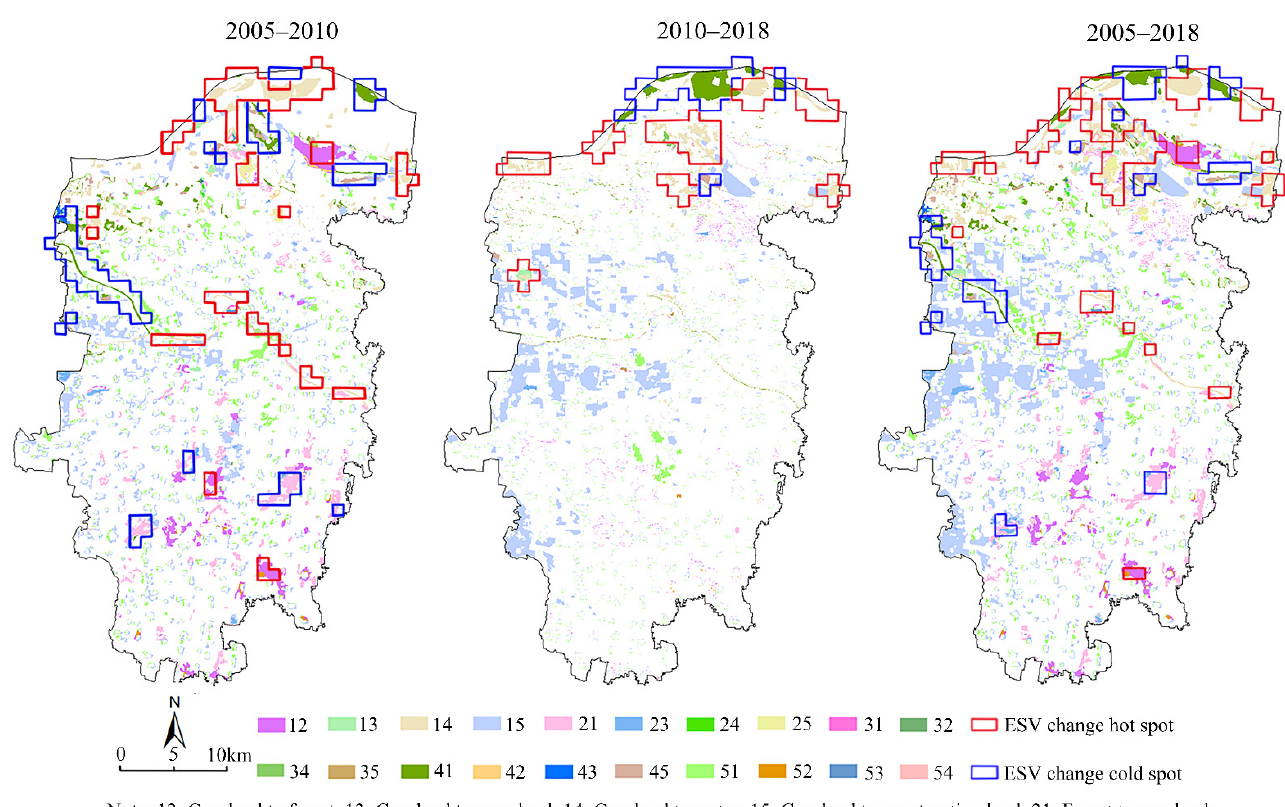
Figure 4. Overlay analysis of ESV changes in cold/hot spots and landscape shifts. Table 7. Global Moran’s I of ESV and landscape level pattern